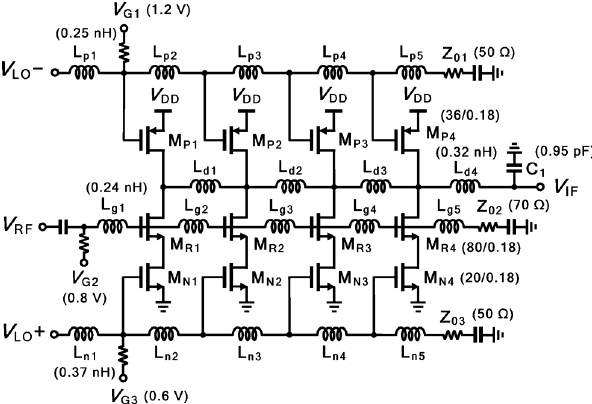
Figure 9. Schematic of the distributed mixer with cascoded complementary switching pairs [132].